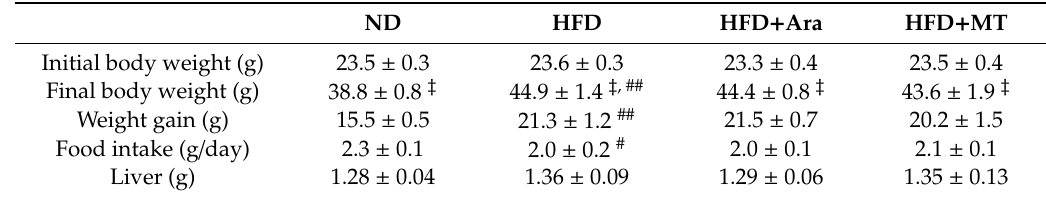
Table 1. Body and organ weights in high-fat diet (HFD)-fed non-alcoholic fatty liver disease (NAFLD)-like mice a .